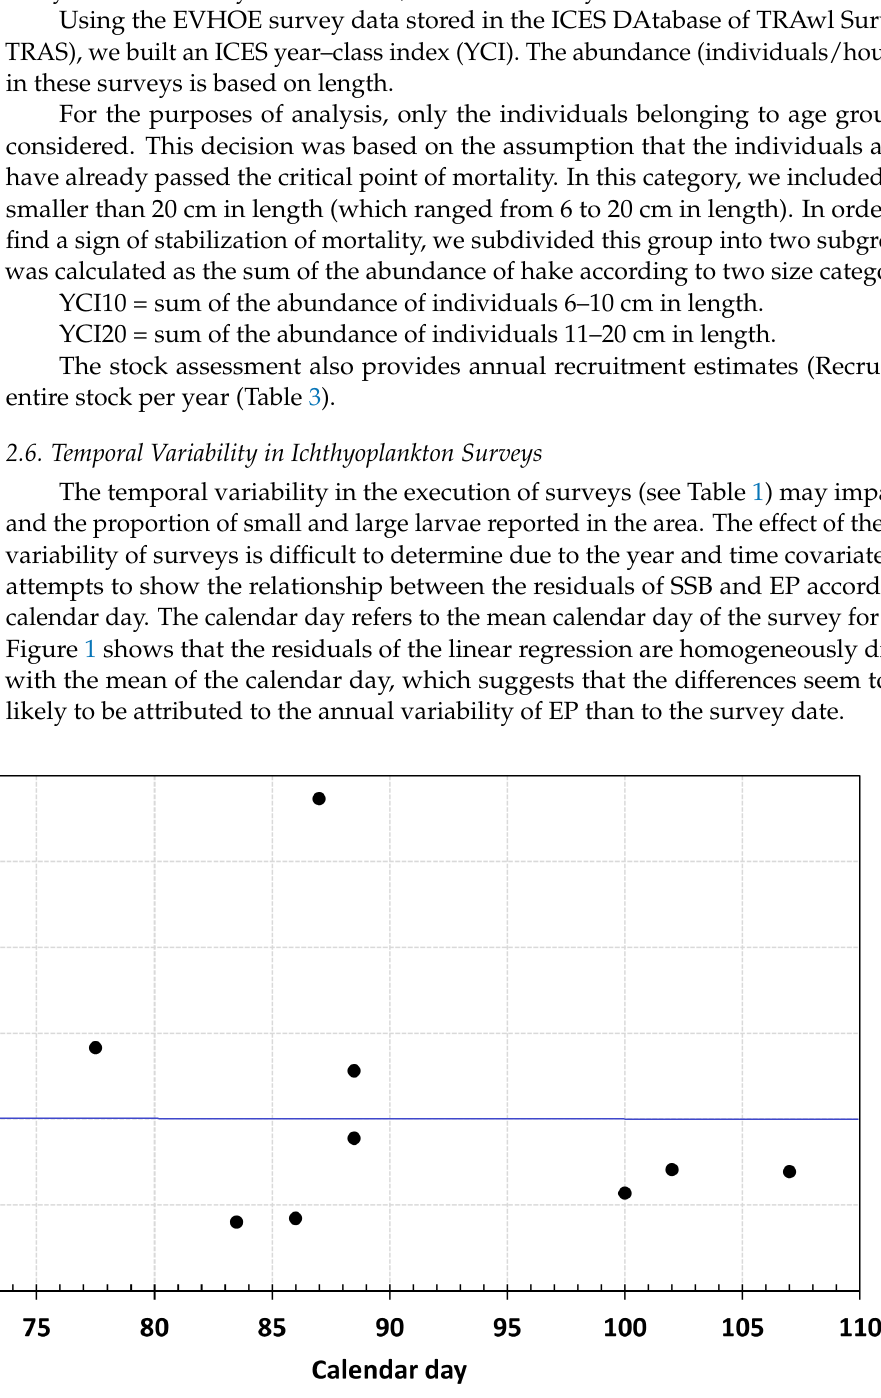
Figure 1. The plot of residuals of the linear regression between SSB and EP vs. the calendar day.